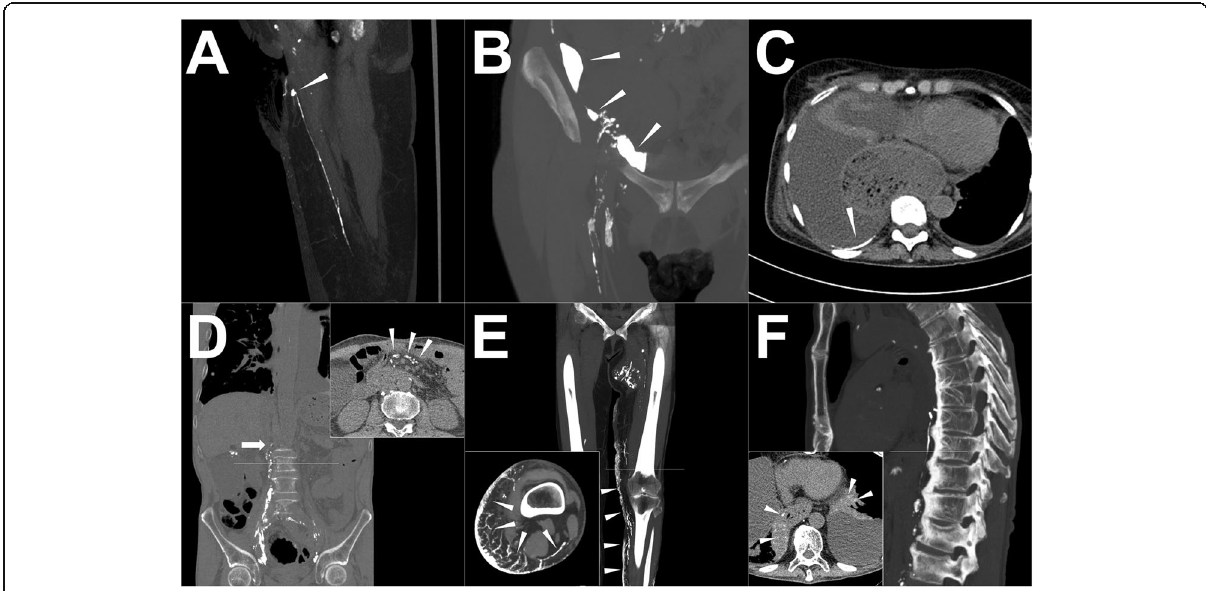
Fig. 2 Exemplary direct and indirect demonstrations of LF. Note: a Local pooling demonstration of the iodized oil extravasation (white arrowhead) from the definite afferent LV; b Diffused distribution of the iodized oil extravasation (white arrowhead) with multiple leakage points; c Evidence of the iodized oil extravasation in the pleural cavity (white arrowhead) without definite LF point; d Abnormal distribution of iodized oil at the mesenterium (upper right corner, white arrowhead) with the disruption of main lymphatic ducts (white arrow); e - dermal reflux (white arrowhead) with the peripheral disruption of main lymphatic ducts; f - abnormal distribution of iodized oil at the lung parenchyma (bottom left corner, white arrowhead) with the iatrogenic disruption of main lymphatic ducts indicating the iodized oil from the thoracic duct directly flowed toward the lung parenchyma through abnormal lymphatic networks (so-called “ PLPS ” ). Abbreviations: LF – lymphatic fistula; LV –